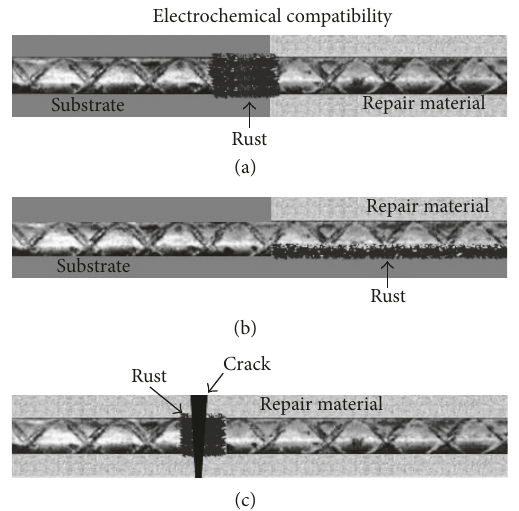
Figure 1: Possible locations of continued corrosion in concrete repair systems ((a) corrosion developing in the substrate due to incipient anode phenomenon at the perimeter of repair, (b) corro- sion developing in the substrate at the bottom of the repair if the bar is half embedded in existing, chloride-contaminated concrete, and (c) corrosion developing in the repair material due to inadequate cleaning, restrained shrinkage cracking, and high permeability), adopted from [7].